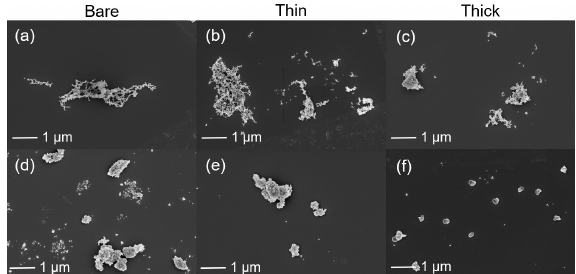
Figure C1. SEM images (Zeiss Leo 1530, Signal = InLens, EHT = 3kV) for 400nm size-selected bare and coated mCAST- black and FW200 soot particles. Scale bars are indicated in each image. (a) Bare mCASTblack, (b) mCASTblack with a thin coating (coating wt = 1.9%), (c) mCASTblack with a thick coating (coat- ing wt = 31.1%), (d) bare FW200, (e) FW200 with a thin coating (coating wt = 1.8%), and (f) FW200 with a thin coating (coating wt = 65.0%).